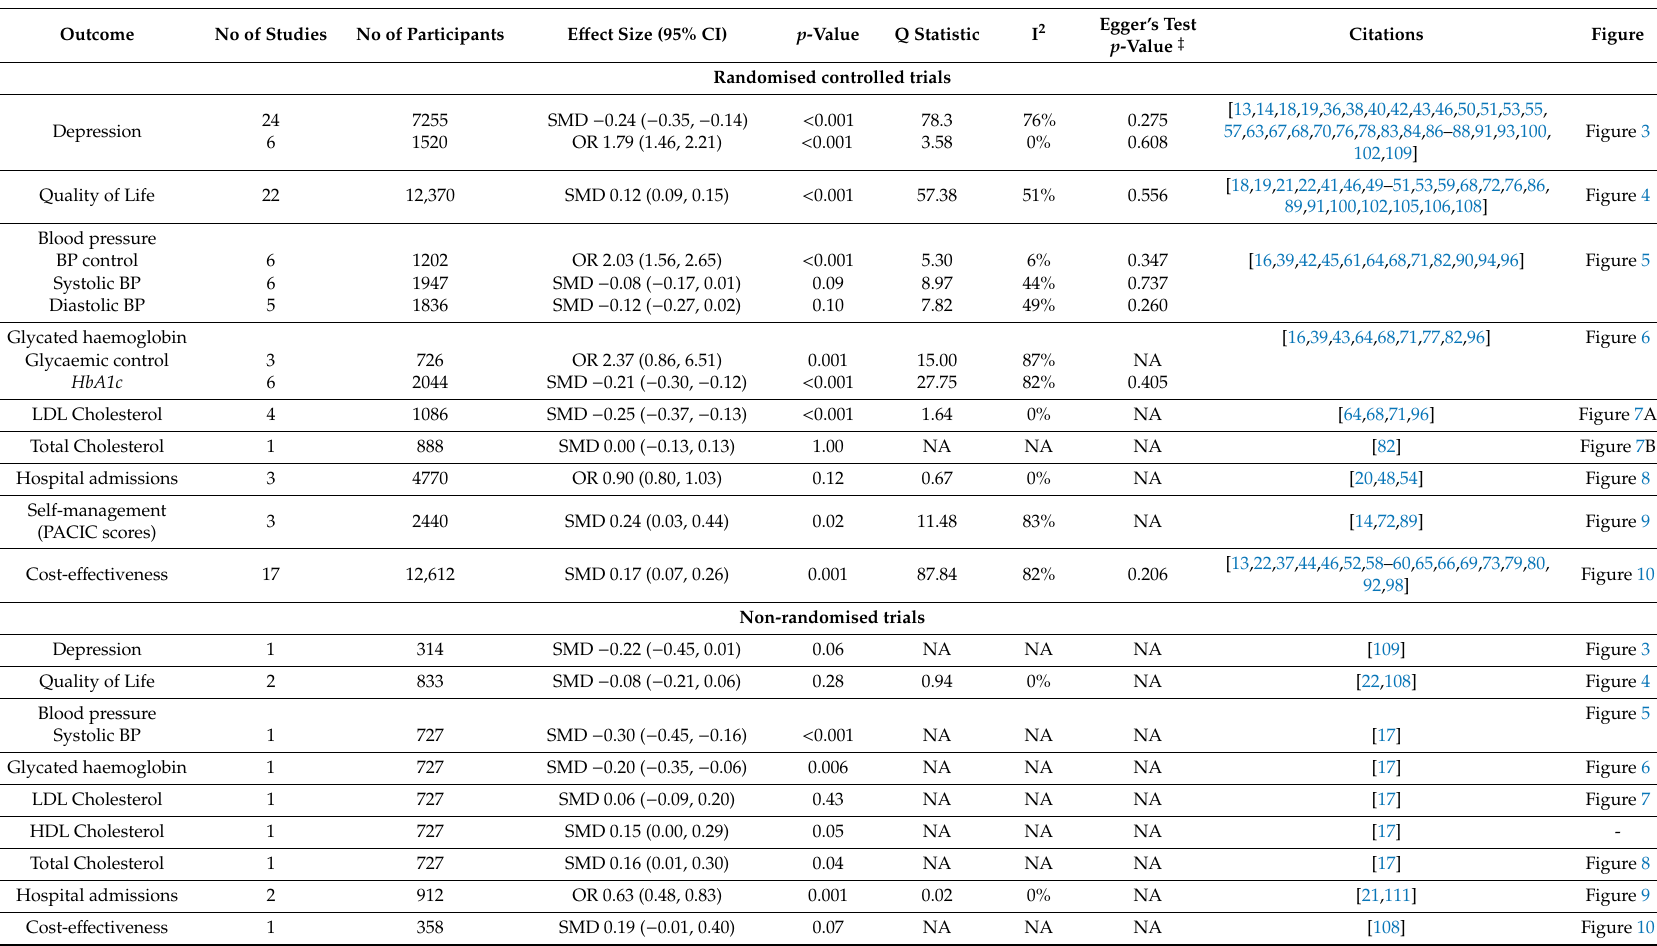
Table 2. Summary of findings from meta-analyses (where possible) or individual studies from randomised and non-randomised controlled trials.